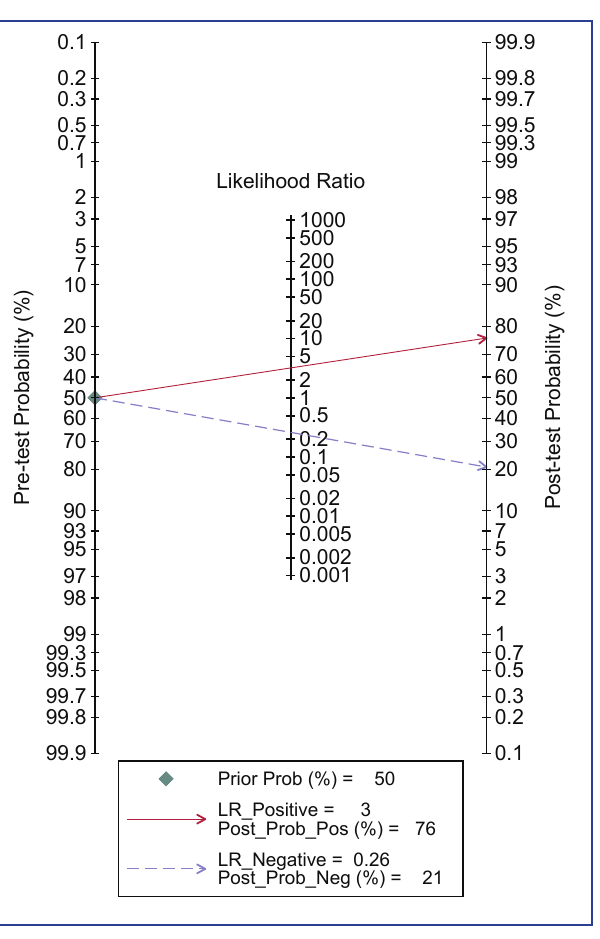
Figure 4 Fagan nomogram of RRI for predicting AKI in critically ill patients. The pretest probability was set to 50%. The post-test probability of NLR for the detection of severe cases was 76% when the NLR was above the cutoff value. The post-test probability was 21% when the NLR was below the cutoff value Table 2 Outcomes of sensitivity analysis and subgroup analysis